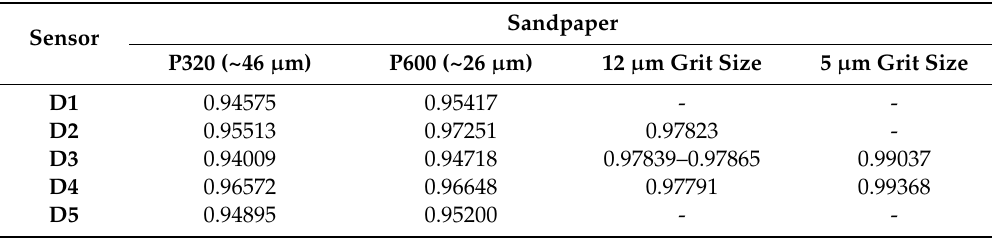
Table 5. Obtained adjusted R-squared values from linear